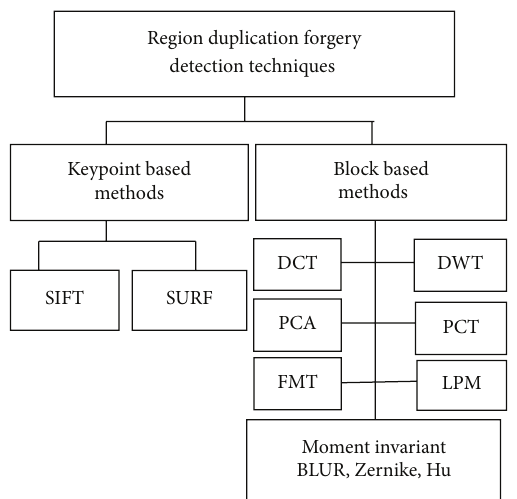
Figure 1: Classification of copy move forgery detection techniques.